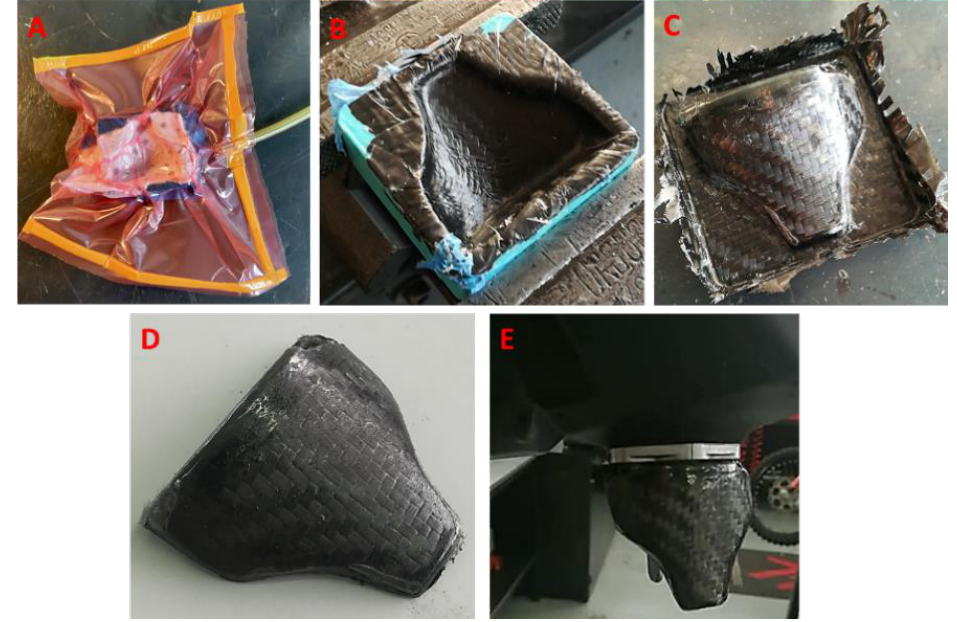
Figure 16. Carbon fiber component production steps: ( A ) component lamination and vacuum, ( B ) mold opened after resin curing, ( C ) component just extracted from the mold, ( D ) trimmed and finished component, ( E ) component mounted on the tank.